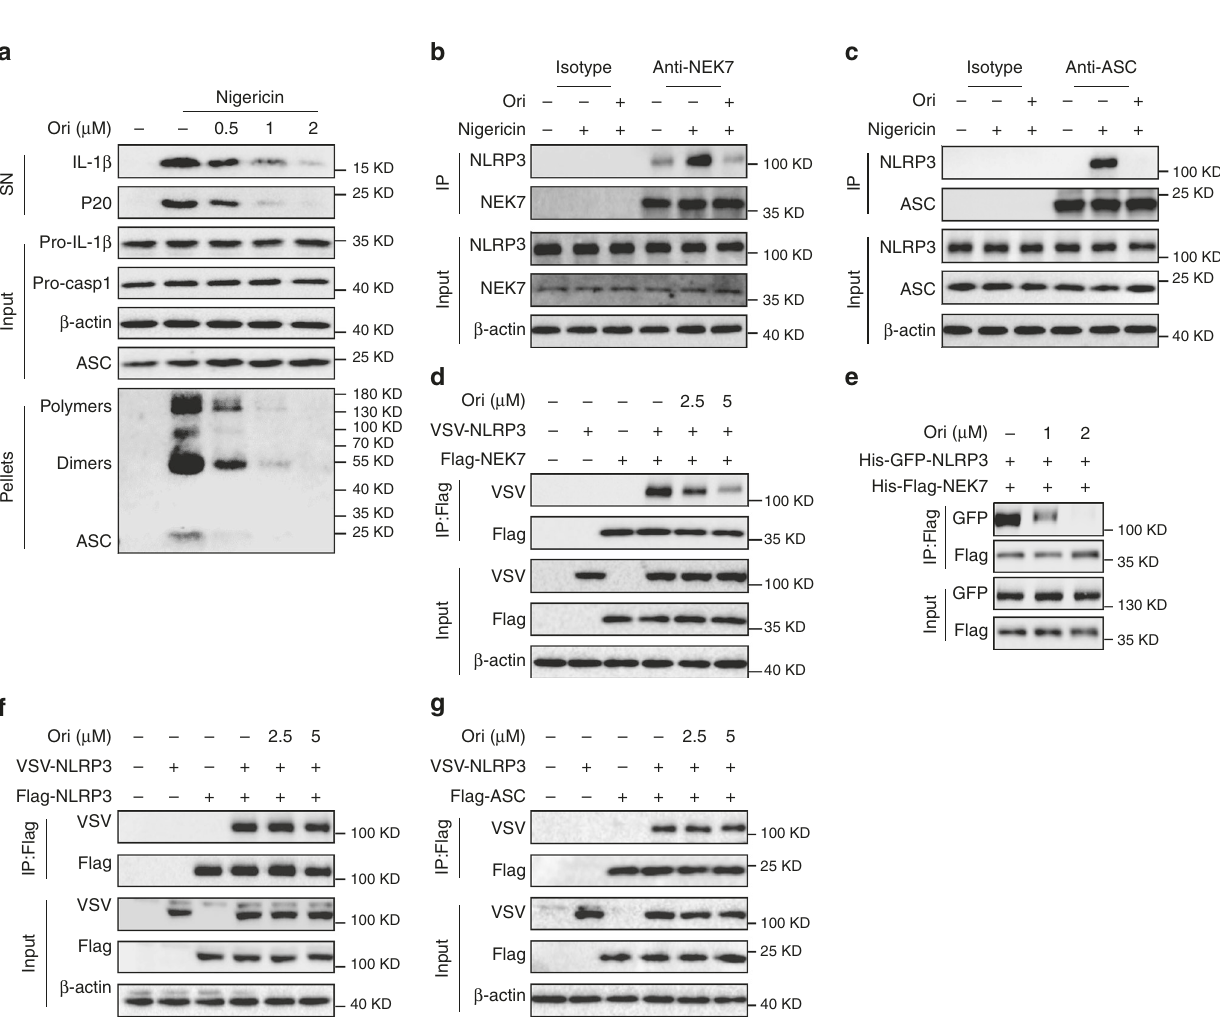
Fig. 2 Ori inhibits NLRP3 in fl ammasome assembly by blocking NEK7 – NLRP3 interaction. a Western blot analysis of cross-linked ASC in the Nonidet P- 40 – insoluble pellet of BMDMs stimulated with nigericin in the presence or absence of Ori. b An endogenous immunoprecipitation (IP) with NEK7 antibody or isotype antibody was performed in LPS-primed BMDMs stimulated with nigericin in the presence or absence of Ori. c An endogenous IP with ASC antibody or isotype antibody was performed in LPS-primed BMDMs stimulated with nigericin in the presence or absence of Ori. d IP and western blot analysis of NEK7 – NLRP3 interaction in HEK-293T cells. e IP and western blot analysis of the interaction between puri fi ed NEK7 and NLRP3. f IP and western blot analysis of NLRP3 oligomerization in HEK-293T cells. g IP and western blot analysis of ASC-NLRP3 interaction in HEK-293T cells. Data are representative of three independent